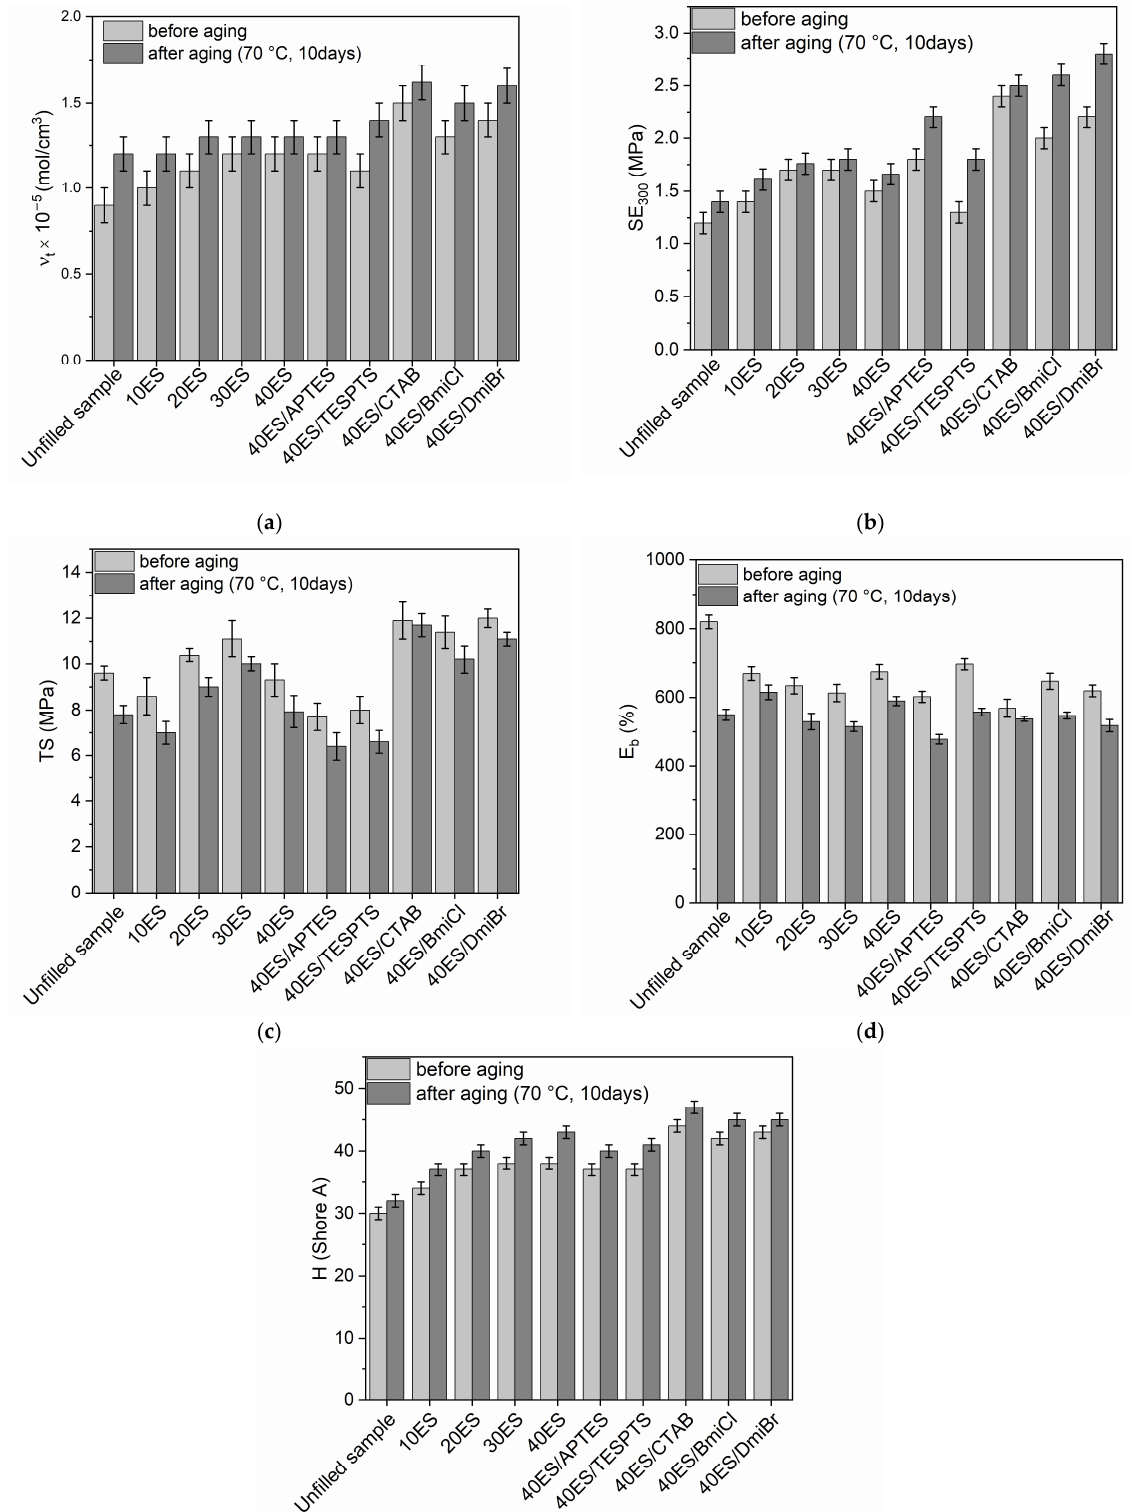
Figure 10. Influence of thermo-oxidative aging on the properties of NR vulcanizates filled with eggshells: ( a ) crosslink density; ( b ) stress at 300% relative elongation; ( c ) tensile strength; ( d ) elonga- tion at break; ( e )